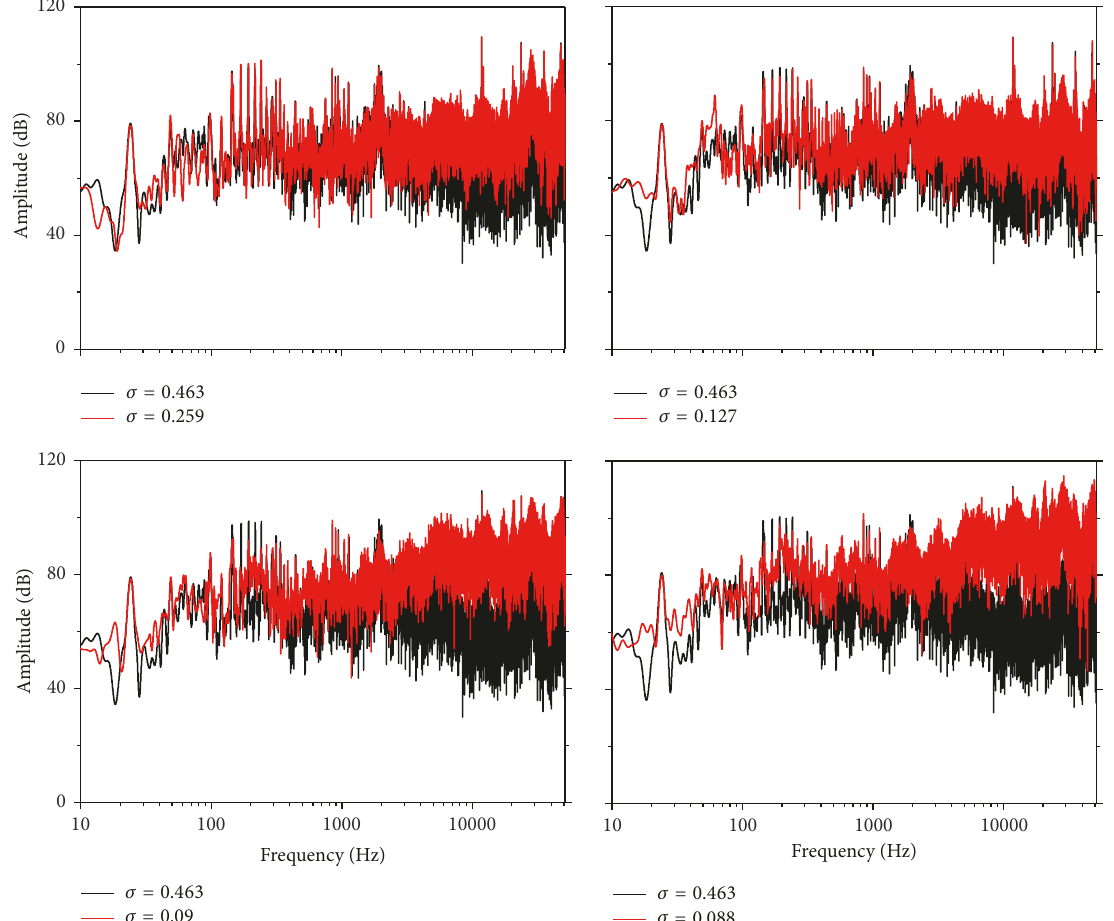
Figure 7: Vibration spectra at 𝑧 -direction of V 1 with cavitation number